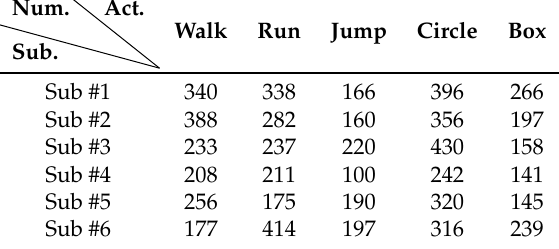
Table 3. Dataset